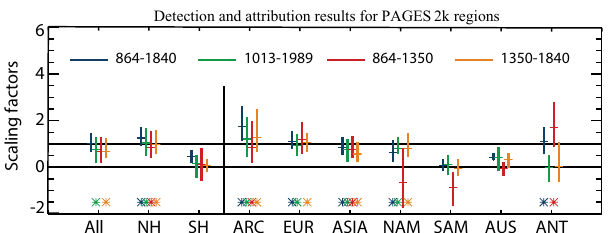
Figure 10. Detection and attribution results for PAGES 2k regions. Vertical bars indicate 5–95% scaling factor ranges, with a cross in- dicating the best fit. Scaling factors that are significantly offset from “0” indicate that the response to forcing is detected, and those that encompass “1” indicate that the magnitude of the forced response agrees with simulations. For each region scaling ranges are shown for four different time periods (colours). For the Northern Hemi- sphere (NH), Southern Hemisphere (SH), and globally (ALL), the regressions were carried out on the combined data from all the ap- plicable regions. An asterisk indicates that the detection analysis has been successful, namely the forced response is significantly greater than zero and that the residuals are consistent with model-based samples of internal